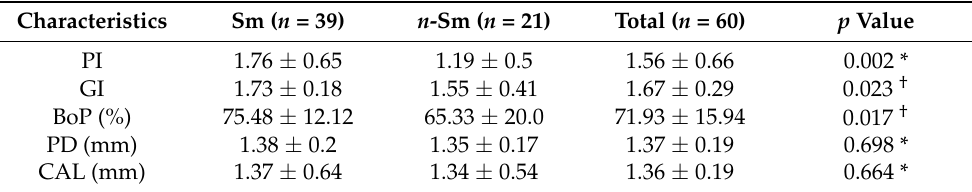
Table 2. Clinical Data for Smokers and Non-Smokers with Gingivitis.